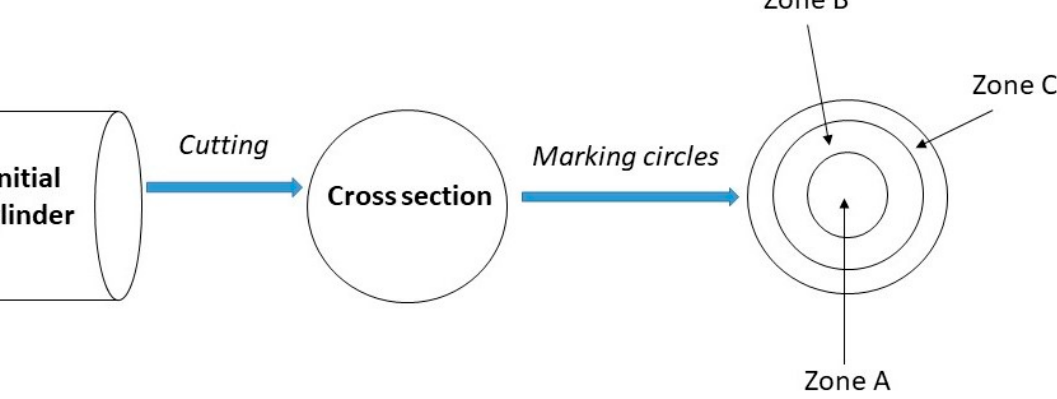
Figure 1. Preparing thermally treated compacted (cylindrical) barite sample for subsequent sampling.